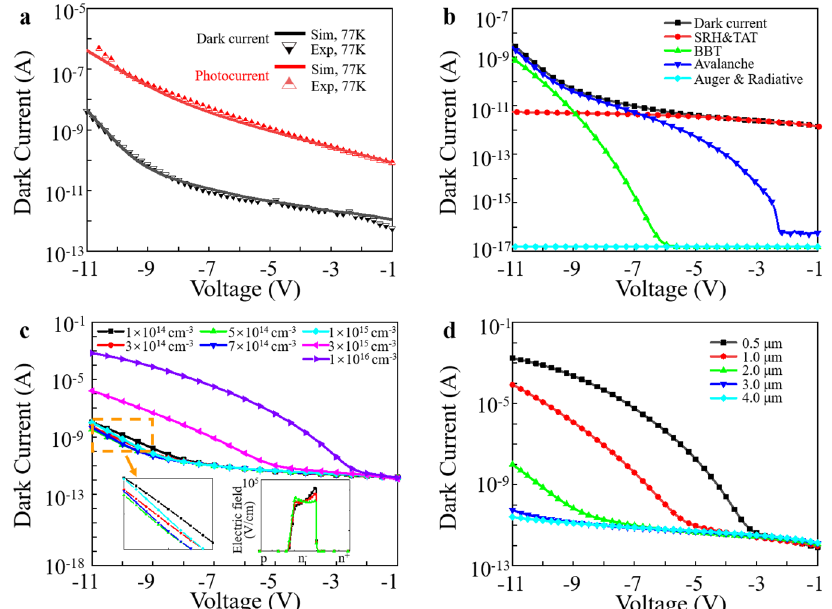
Fig. 2 The accurate model in analyzing the dark current. a Simulated and measured results of dark current and photocurrent. b Total dark current and dominant components for HgCdTe APD. c Simulated I – V curves with various doping concentrations of n − layer. Insets show IV curves at high bias and the electric fi eld for different doping concentrations at − 11 V, respectively. d Simulated dark current as a function of voltages with different n − layer